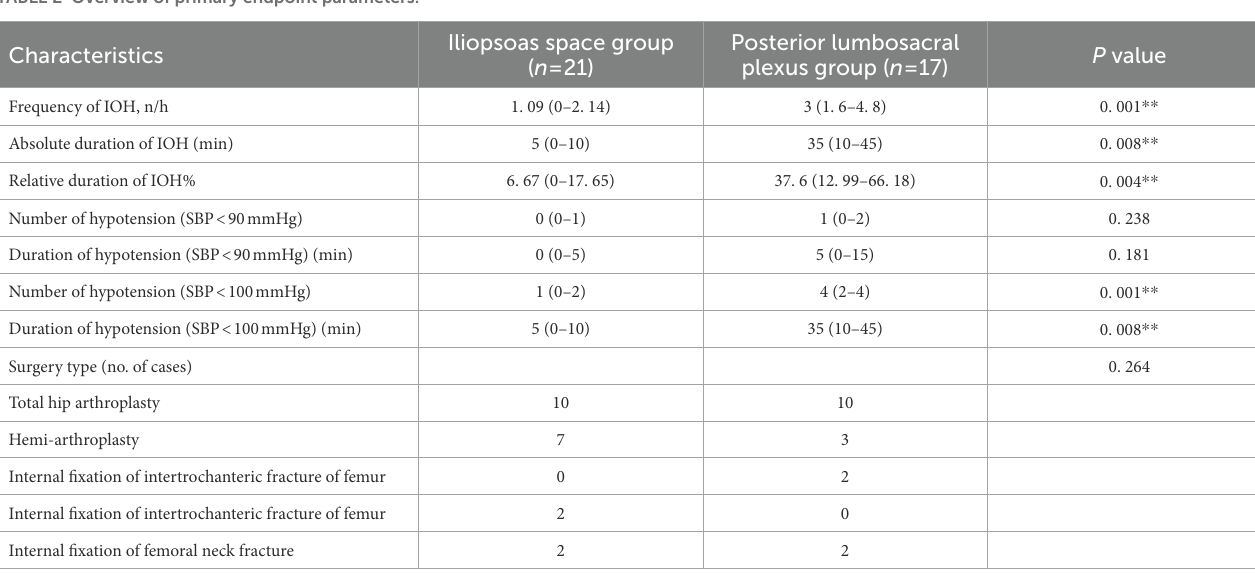
TABLE 2 Overview of primary endpoint